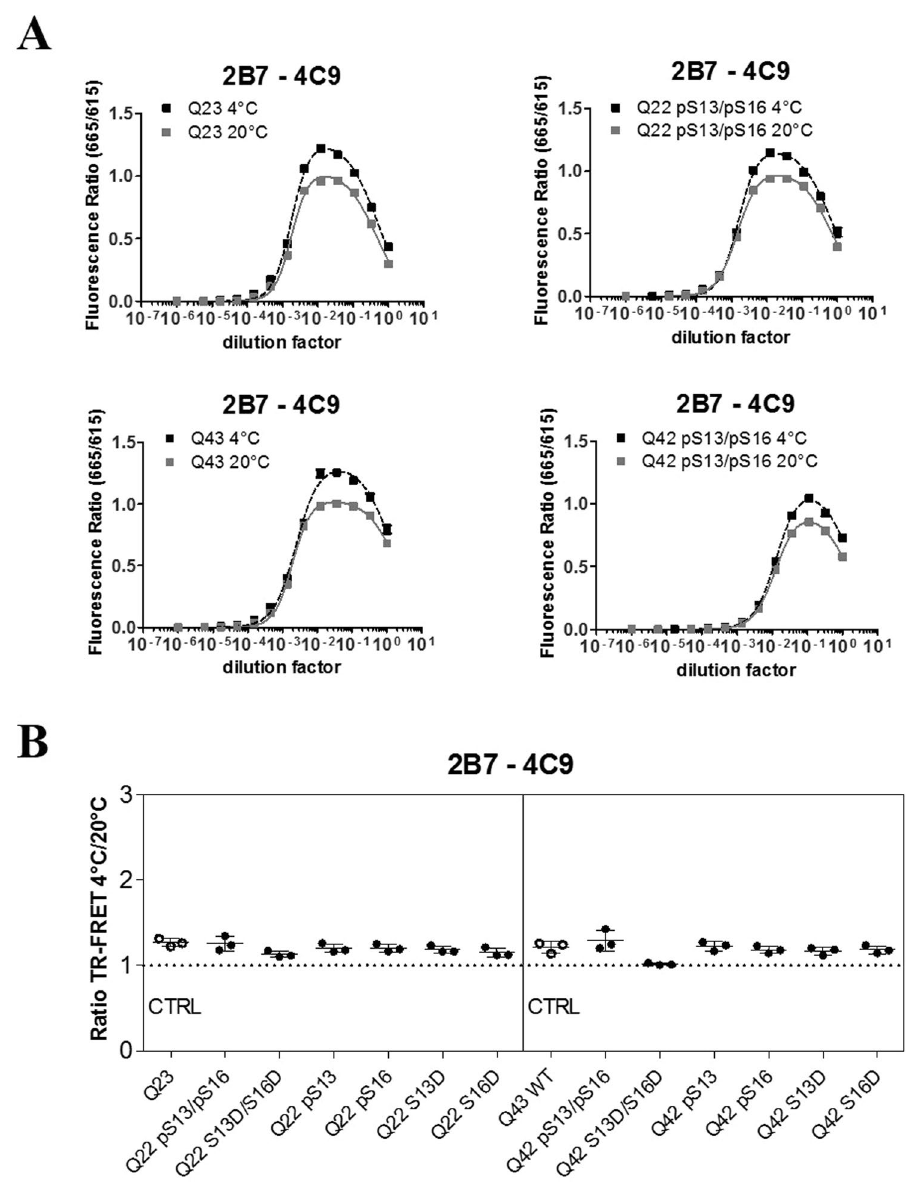
Figure 10. The 2B7/4C9 control immunoassay in semisynthetic HTT exon 1 proteins. ( A ) Upper panels: 2B7/4C9 TR-FRET assay signal obtained on semisynthetic unmodified(Q23) or pS13/pS16 HTT exon 1 Q22 at the two temperatures. Lower panels: 2B7/4C9 TR-FRET assay signal obtained on semisynthetic unmodified (Q43) or pS13/pS16 HTT exon 1 Q42 at the two temperatures. ( B ) Summary of 2B7/4C9 (control) TR-FRET immunoassay (ratio TR-FRET signals at 4 °C/20 °C), which does not detect the polyQ-dependent conformational change, obtained on all wild type (Q23/22) and all mutant (Q43/42) semisynthetic proteins from three independent experiments, each with three technical replicates (two-way ANOVA with Bonferroni’s post-test, degrees of significance are